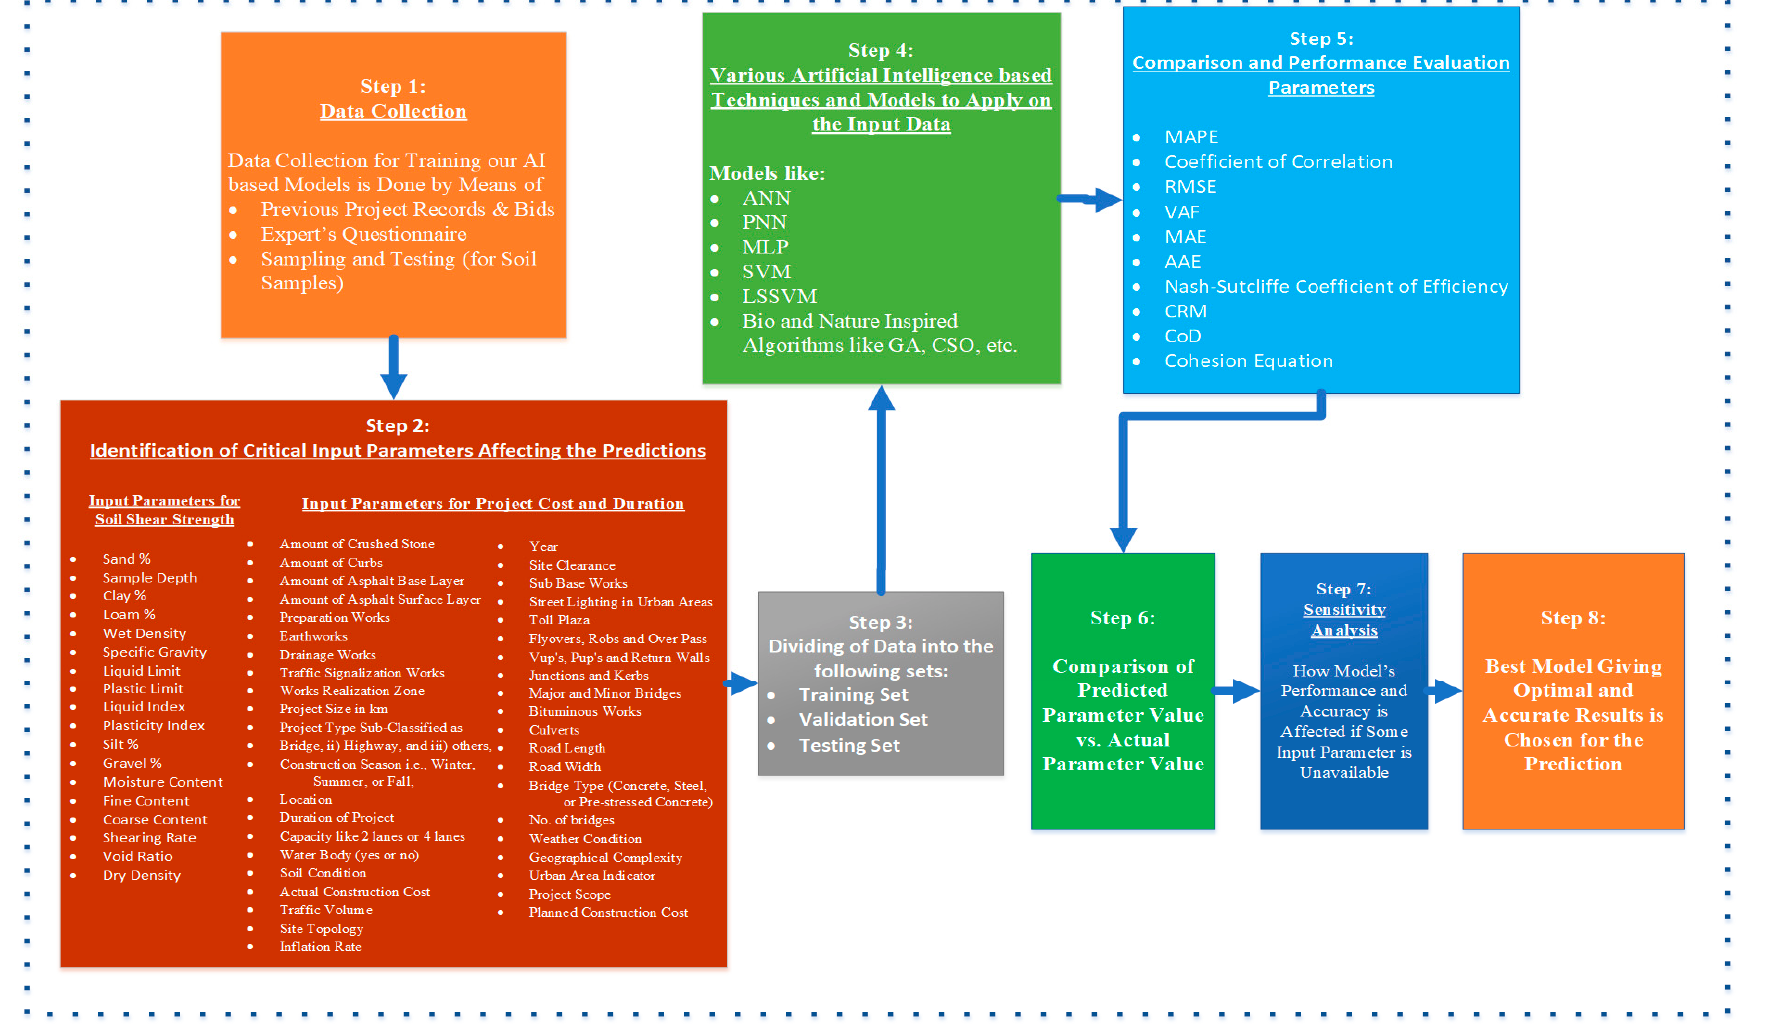
Figure 5. Basic steps involved in the use of AI ‐ based models in the prediction and estimation of shear strength and pre ‐ project cost and duration throughout the construction of roads.